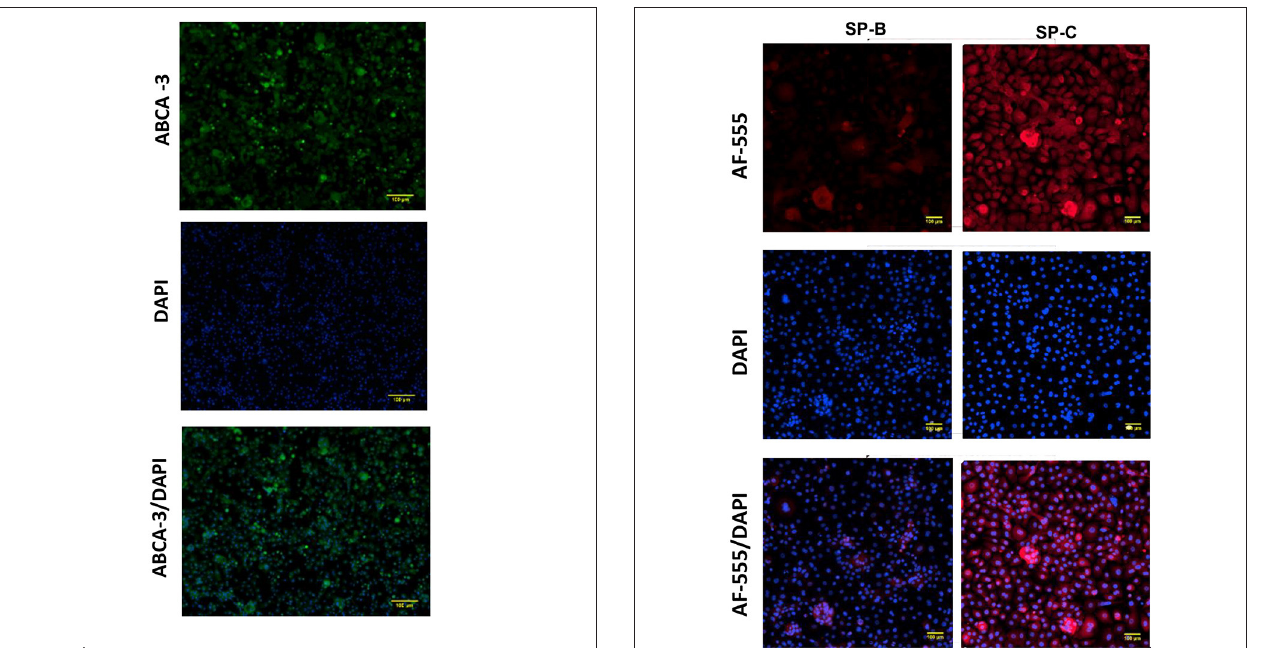
FIGURE 3 | Expression of surfactant proteins in primary nasal epithelial cells. Expression of SP-B and SP-C was determined in formaldehyde-fixed primary nasal cells cultured in chamber slides and visualized by fluorescent microscopy at 100 × total magnification. A secondary antibody conjugated to AF-555 was used to detect primary antibodies bound to SP-B and SP-C. All protein targets were detected in the cytoplasm of primary nasal epithelial cells with a diffuse cytoplasmic pattern of expression and some cells staining more intensely than others. DAPI was used as a nuclear stain. Scale bar 100 µ m. Representative images are